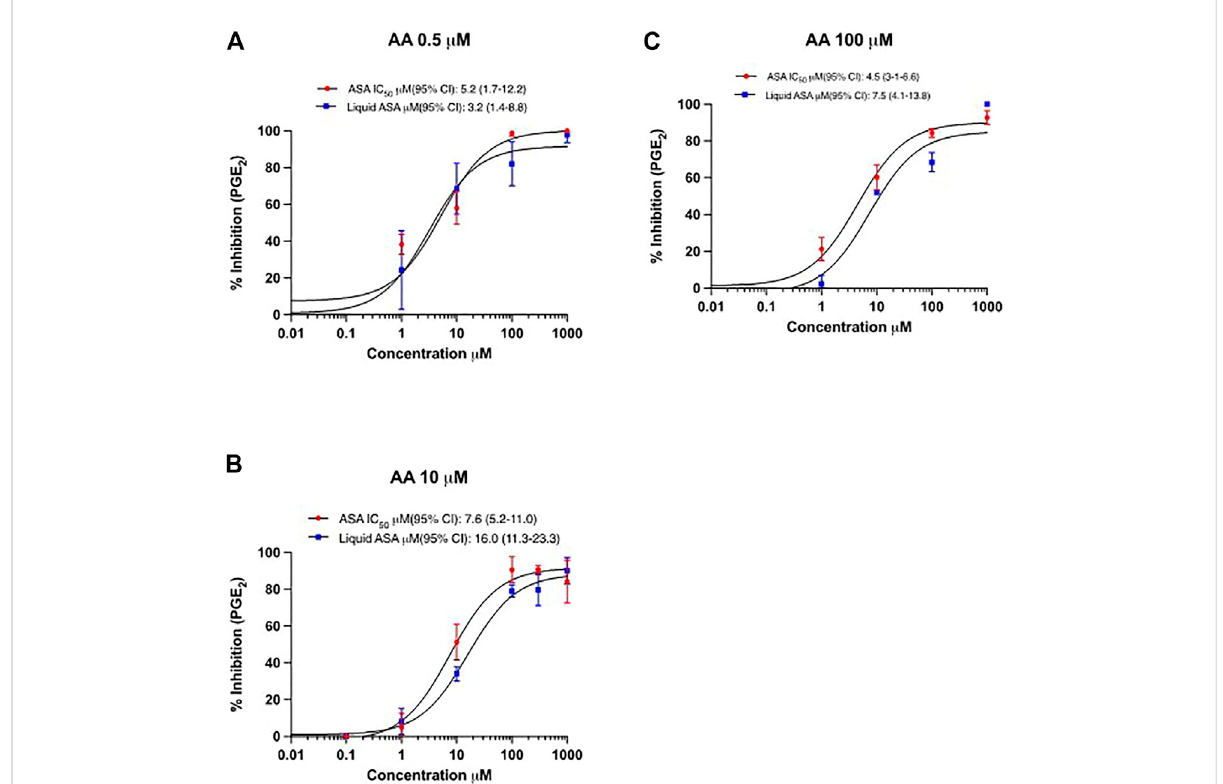
FIGURE 7 Concentration-response curves for inhibition of PGE 2 in HCA7 cells in response to different concentrations of AA by ASA and L-ASA. The biosynthesis of PGE 2 in HCA7 cells was evaluated by preincubating the cells (1 ×10 6 ) with vehicles (DMSO or diluent) or increasing concentrations of ASA or L-ASA for 30 min at 37 ° C; then, cells were incubated with AA 0.5 (A) , 10 (B) or 100 µM (C) for 30 min at 37 ° C and the levels of PGE 2 were assessed in the medium by LC-MS/MS. Data (% of inhibition from baseline with DMSO or diluent) are reported as mean ± SD, n = 4. Concentration-response curves were fi tted, and IC 50 values with their 95% CI values are